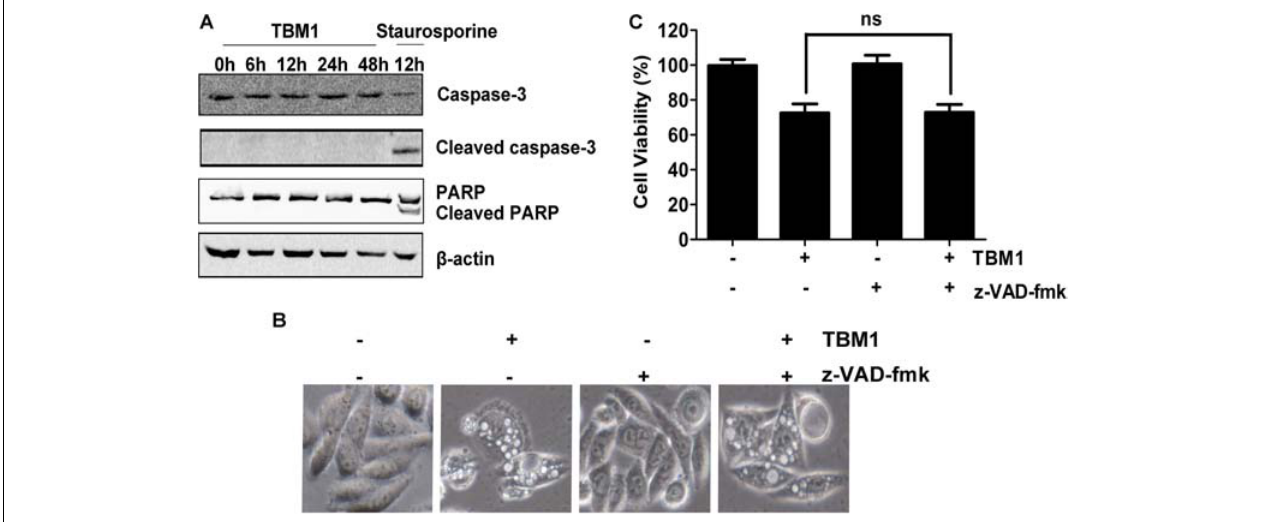
FIGURE 5 | TBM1 induces Caspase-independent cell death in CRC cells. (A) SW480 cells were treated with 8 µ M TBM1 for different time or 1 µ M staurosporine for 12 h. Protein expression of caspase 3, cleaved caspase 3, PARP and cleaved PARP was detected by Western blotting. Beta-actin were served as loading control. (B) SW480 cells were pre-cultured with or without pan-caspase inhibitor, z-VAD-fmk (50 µ M) for 1 h before exposure to TBM1 for 48 h. Morphological changes were observed by phase-contrast microscopy. (C) Cell viability was measured by MTT assay ( n = 5). Data presented were showed as means ± SD. ns means that there are no statistics